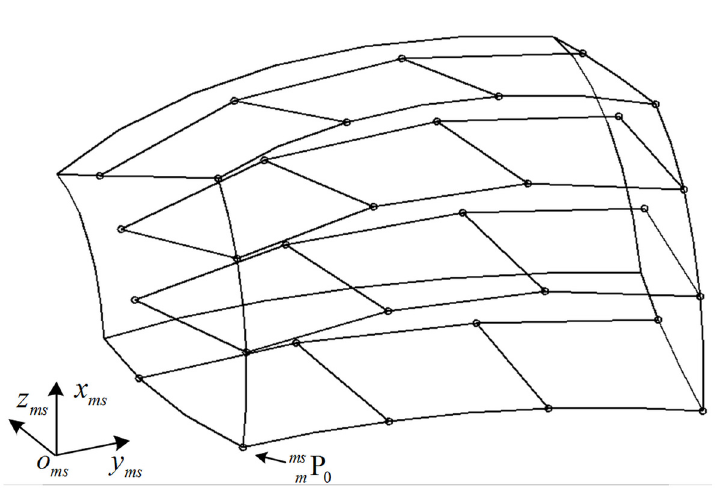
Fig 7. The spatial distribution of initialized control points. The range of curve is the same with that of Fig 6, and it is an eighth of the moving space which is symmetrical around ms take control of the surrounding space which is partitioned by adjacent control